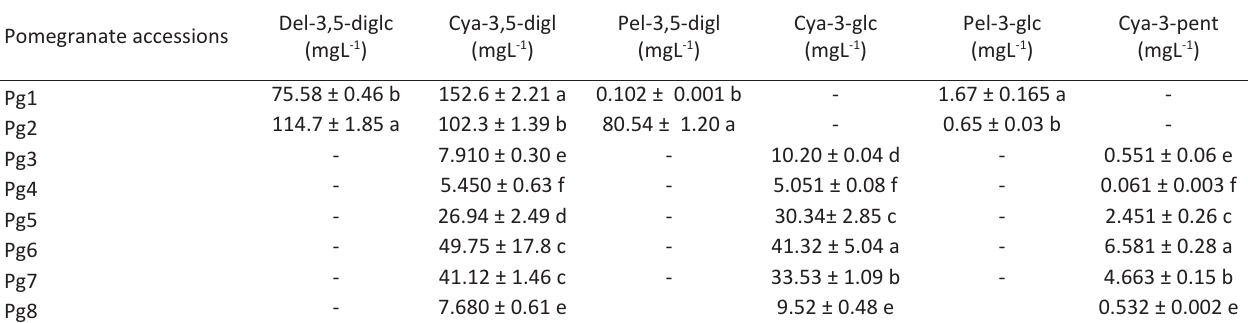
Values are reported as mean ± SD (n=3). Numbers followed by different letters in the same column are statistically different according to Tukey’s test (p ≤ 0.05). Del­3,5­diglc=delphinidin­3,5­O­diglucoside, Cya­3,5­digl=cyanidin­3,5­O­diglucoside, Cya­3­glc=cyanidin­3­O­glucoside, Cya­3­pent=cya­ nidin­3­O­pentoside, Pel­3,5­digl=pelargonidin­3,5­O­diglucoside,